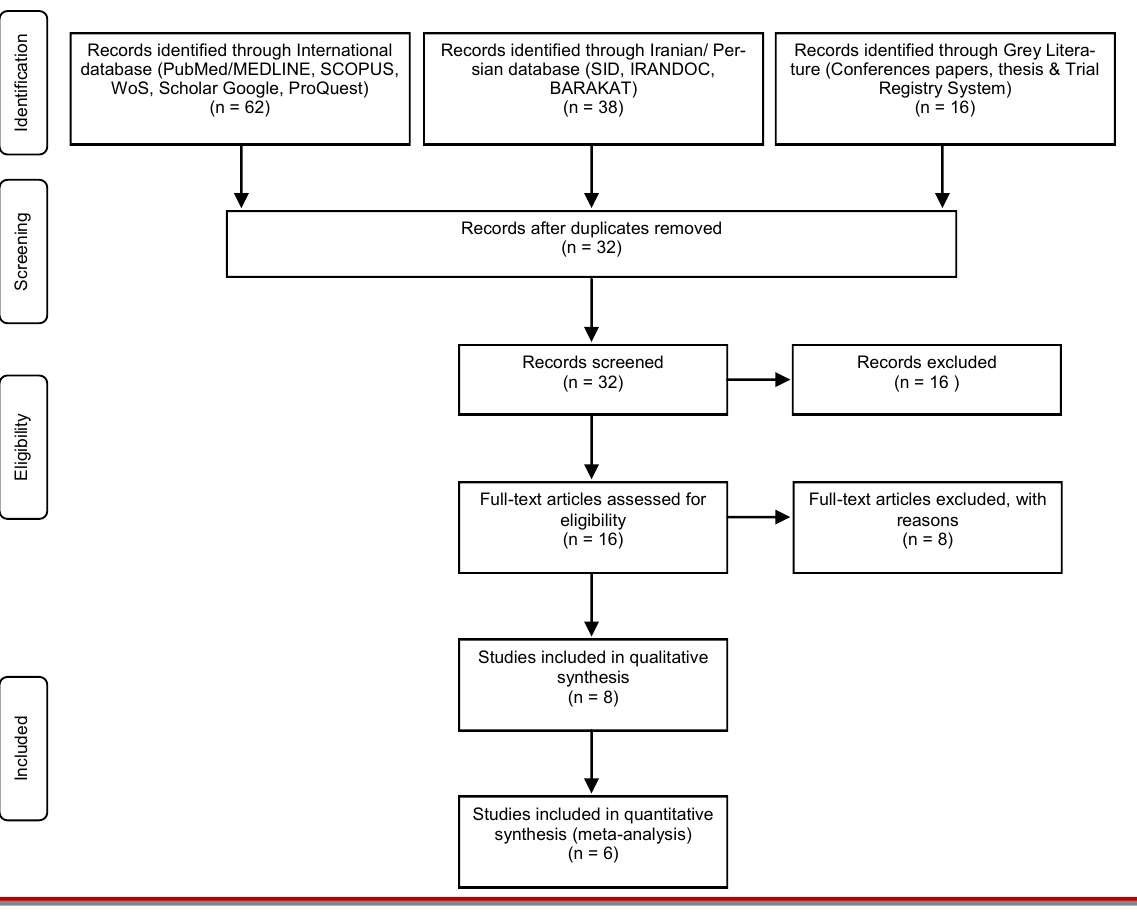
Figure 2: Search flowchart for articles (as described in the PRISMA statement)